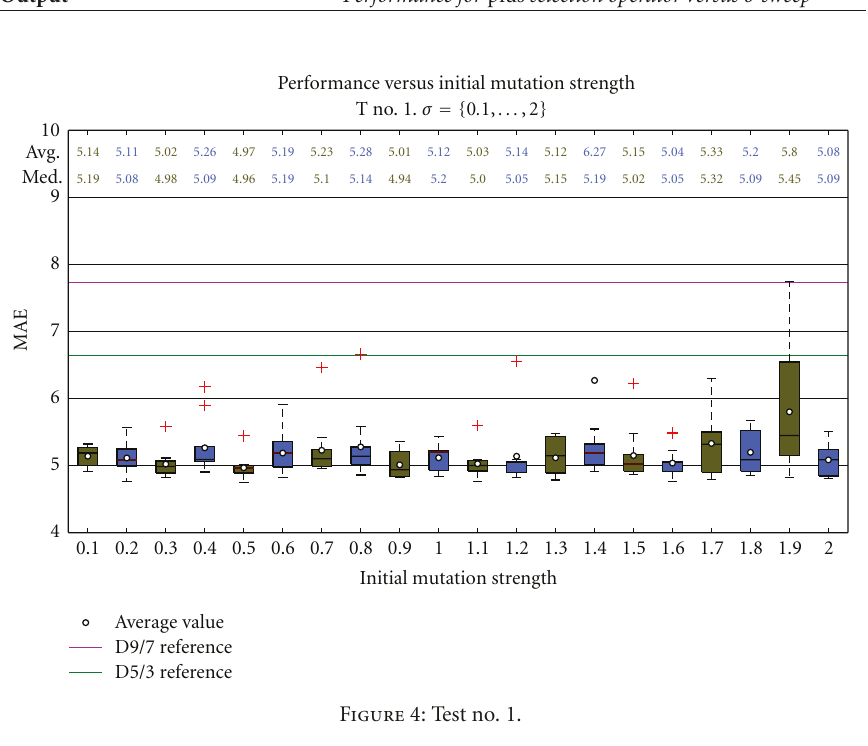
Figure 4: Test no.